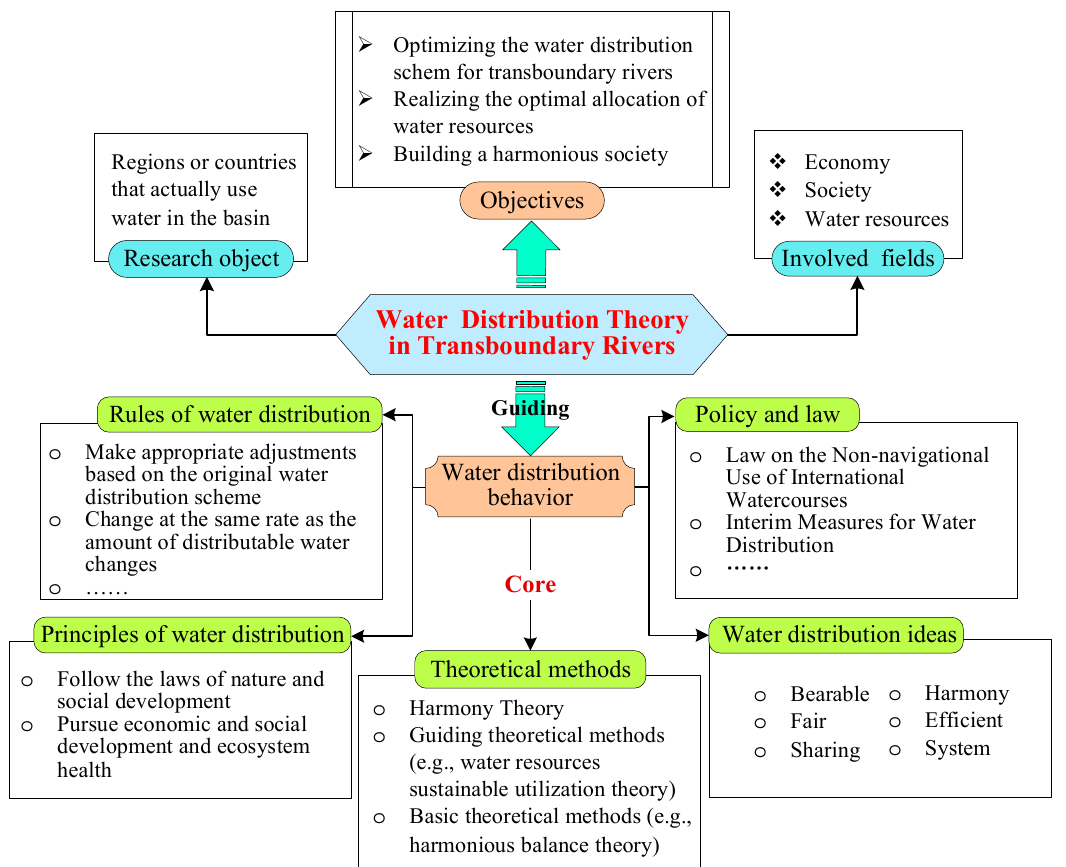
Figure 1. The framework of the theoretical system of water distribution in transboundary rivers.